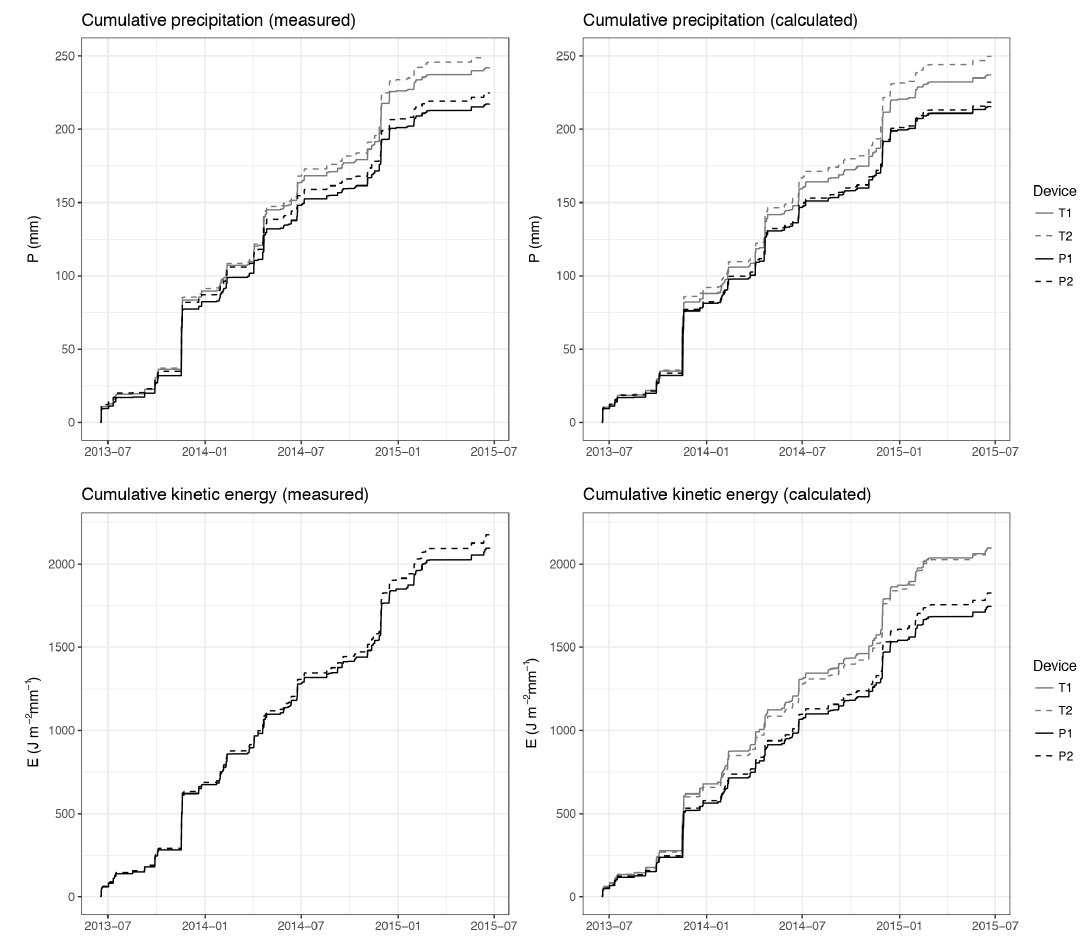
Figure 2. Accumulated precipitation ( R , mm) and kinetic energy ( E , Jm − 2 mm − 1 ) during the 2-year experiment (only the minutes with data on the four disdrometers are